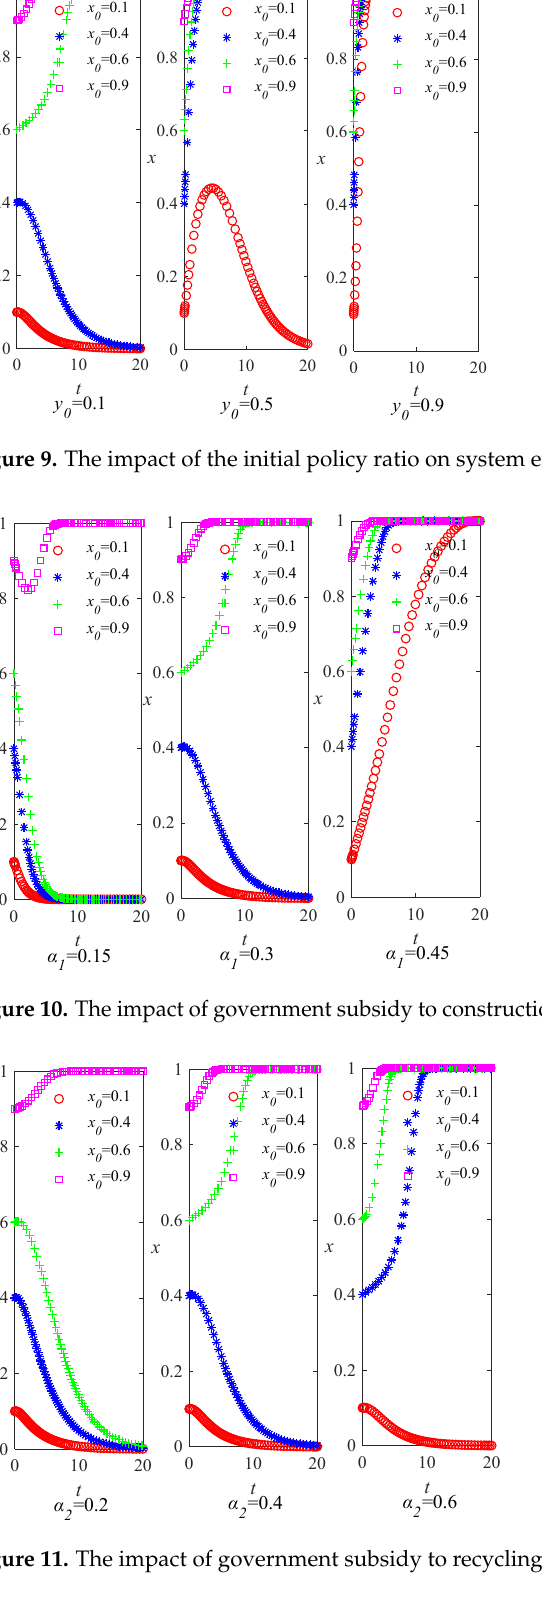
Figure 12. The impact of government punishment on construction enterprises on system evolution results. (3) The impact of government supervision on system evolution results